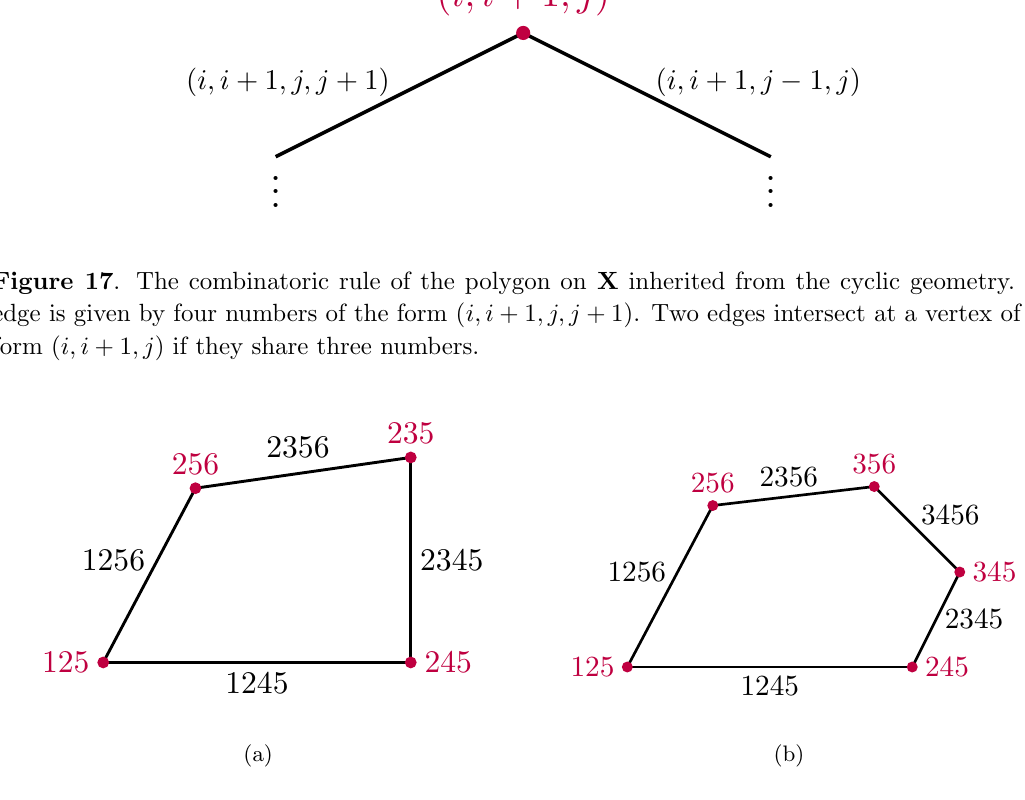
Figure 18 . The projection of the cyclic polytope on the two-dimensional crossing plane X is a polygon. The edges and vertices of the polygon are constrained by the cyclic geometry (8.11). Here we show two examples allowed by the